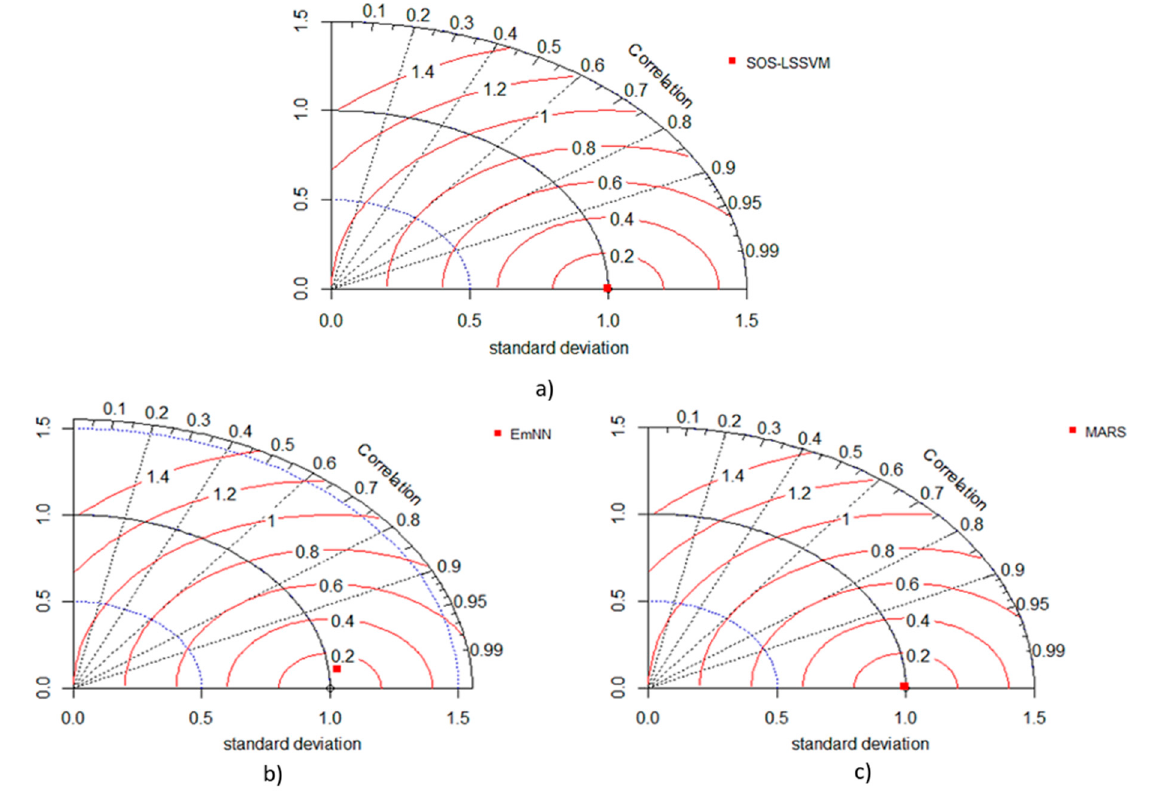
Figure 2. Taylor diagram for ( a ) SOS–LSSVM, ( b ) EmNN, and ( c ) MARS method.